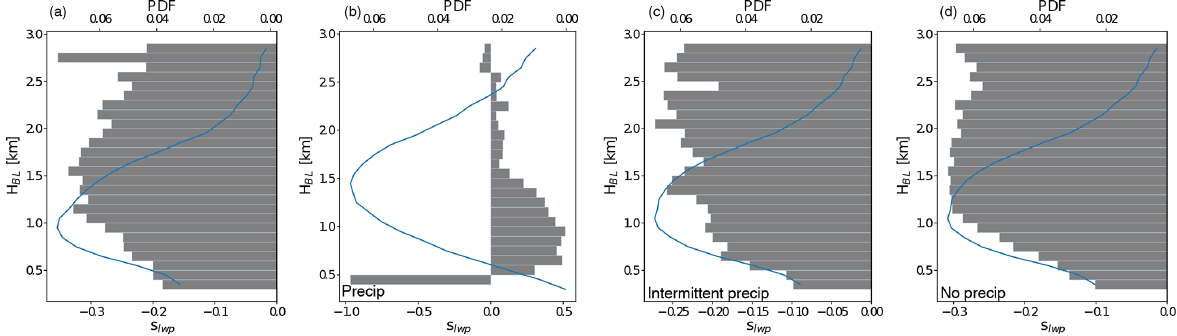
Figure 6. (a) s lwp determined within 100m height intervals for subtropical stratocumulus, (b) precipitating clouds only, (c) intermittently precipitating clouds, and (d) non-precipitating clouds. S lwp was obtained from bivariate linear regression of the lnLWP surfaces shown in Fig. 4a–d within each height interval, respectively. Only statistically significant results at the 95% confidence level are shown. The probability density function (PDF) of the subtropical cloud climatology across the height bins is